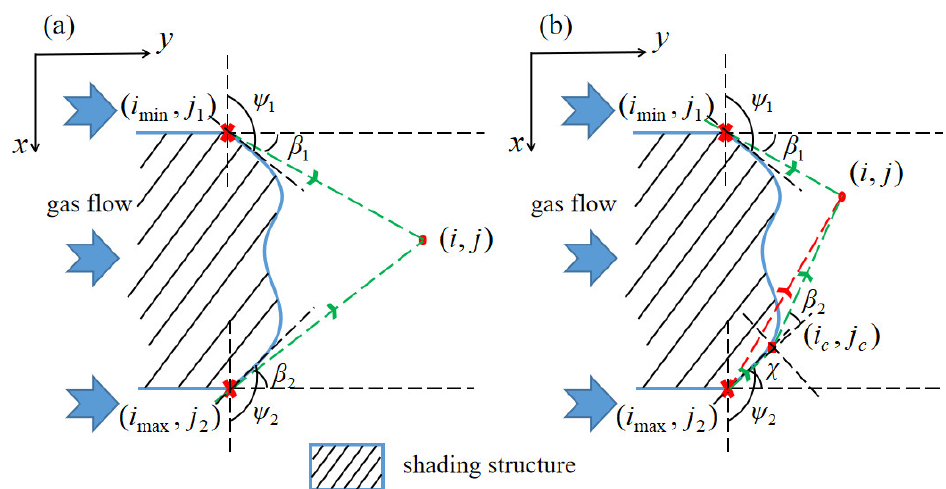
Figure 3. The schematic diagram of the PGFM. ( a ) The precursor gas flow can directly reach the cell ( i , j ) after passing through the cell ( i min , j 1 ) and the cell ( i max , j 2 ); ( b ) the precursor gas flow reaches the cell ( i , j ) after passing through the cell ( i c , j c ) and ( i min , j 1 ).